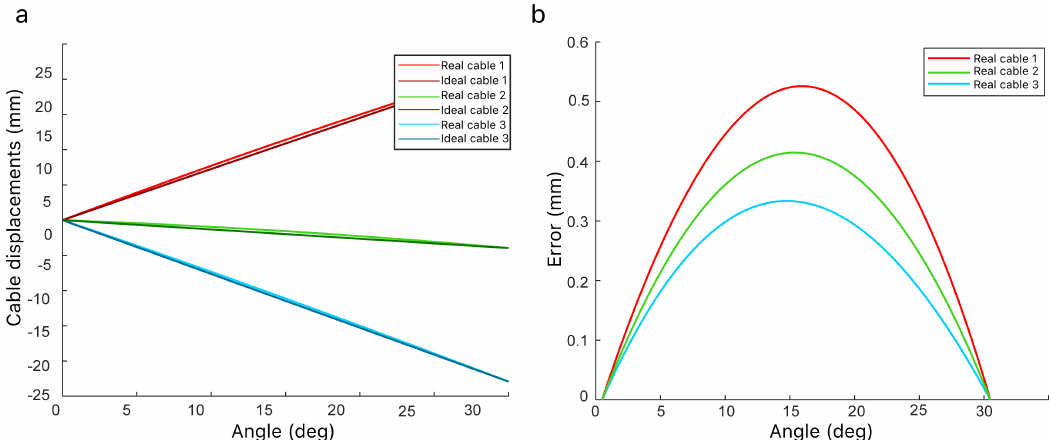
Figure 11. ( a ) Difference between the real displacements of the cables of the same module versus the angle magnitude. ( b ) Error between the real displacements and the linear